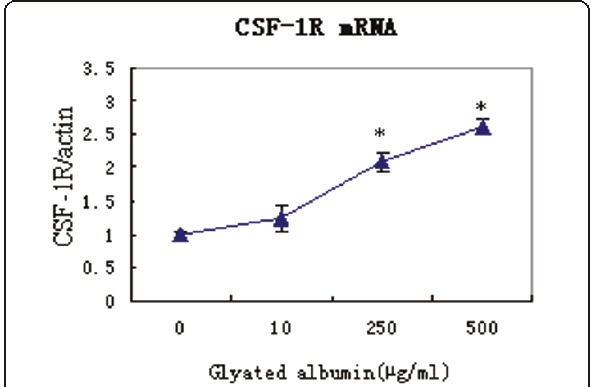
Figure 6 Glycated albumin induces the up-regulation of CSF- 1R mRNA expression in purified microglial cells . Microglial cells were incubated with or without GA at indicated concentrations for 24 h, up-regulation of CSF-1R mRNA expression in microglia was observed. One-way ANOVA was performed, followed by post-hoc analysis. *, P < 0.0001.